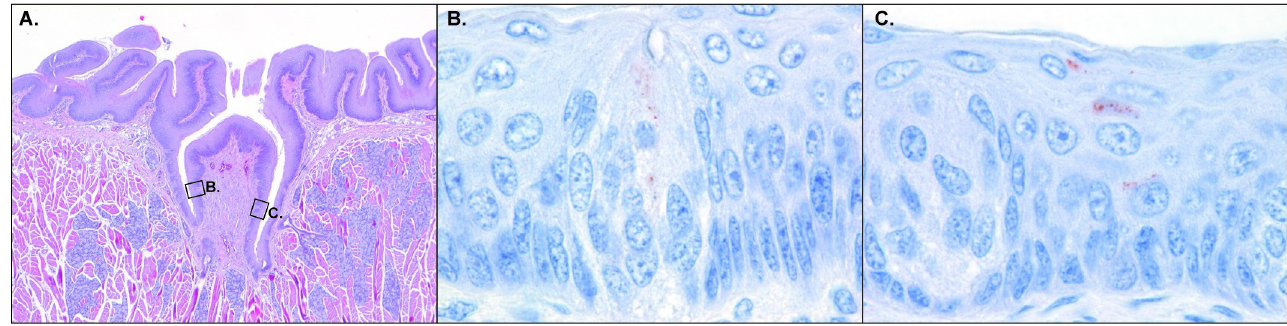
Fig 3. Microscopy figure of experimentally infected straw-colored fruit bat tongue. A. Circumvallate papilla characterized by a dome in the surface lined by epithelium. Salivary glands are present in the pit of the dome. HE stain. Original magnification 4x objective. B. Higher magnification of a taste bud that was present in the circumvallate papilla shown in A. The neuroepithelial cells of the taste bud express lyssavirus antigen (red granules). Lyssavirus IHC stain. Original magnification 100x objective. C. Higher magnification of another taste bud that was present in the circumvallate papilla shown in A. Surface epithelial cells near the taste bud express lyssavirus antigen (red granules). Lyssavirus IHC stain. Original magnification 100x objective.